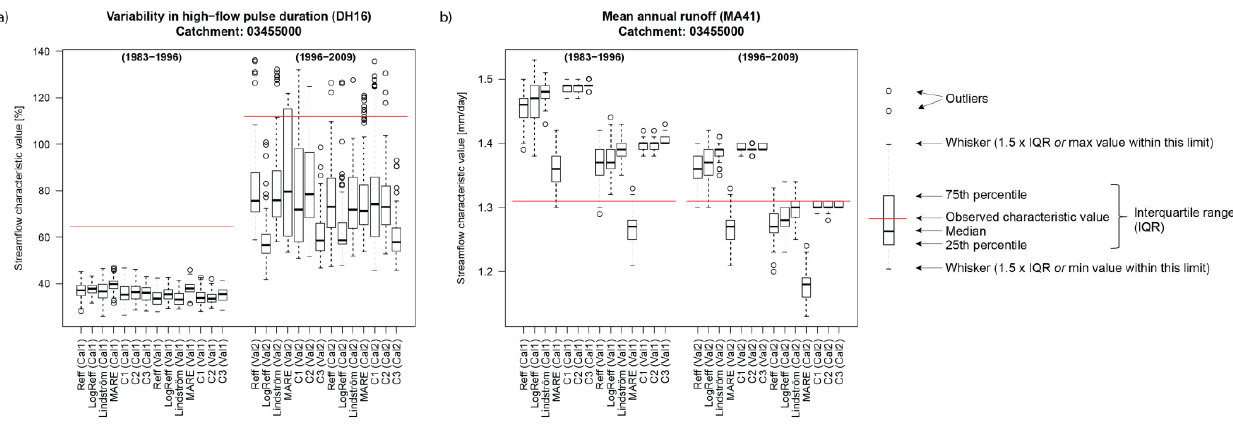
Figure 2. Boxplots for catchment 4 (03455000) and ( a ) streamflow characteristic DH16 (Variability in high-flow pulse duration); ( b ) streamflow characteristic MA41 (Mean annual runoff). Cal1 and Cal2 are calibration of period 1, respectively period 2, whereas Val1 and Val2 are validation of period 1, respectively period